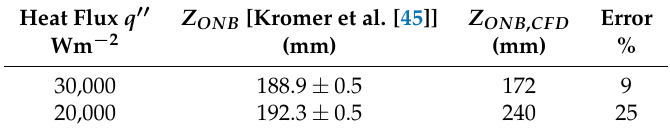
Figure 2. CFD validation for the heated surface temperature with the experimental data provided by [44]. Table 1. CFD validation for the void fraction with the experimental data provided by